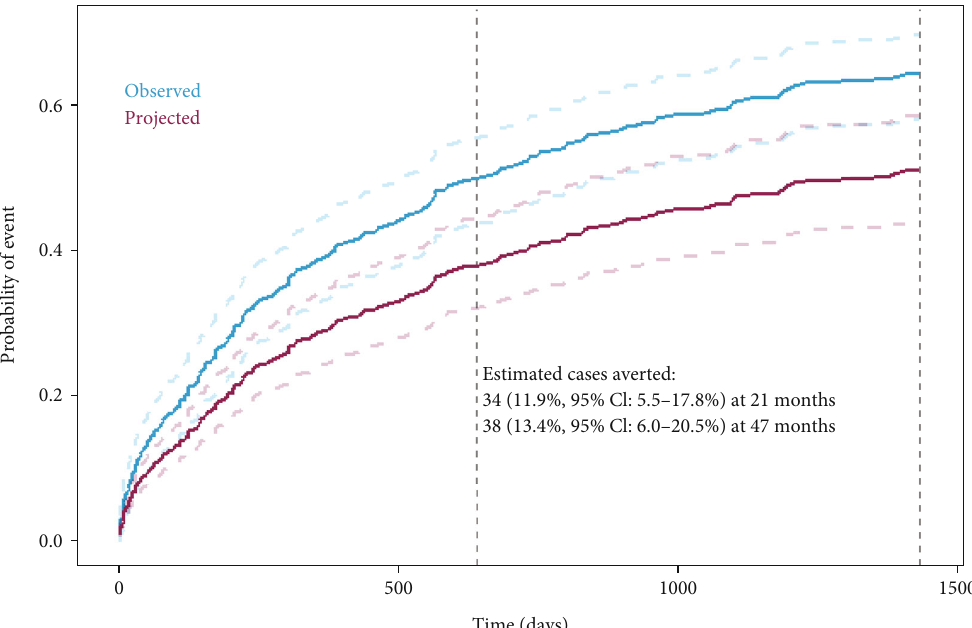
Figure 1: Cumulative incidence plot of the primary composite endpoint including adverse cardiovascular and limb events. (i) The projected cumulative incidence was calculated by fi rst multiplying the observed cumulative hazard by the hazard ratio, its lower con fi dence interval (CI) limit, and its upper con fi dence interval limit reported in the COMPASS trial subgroup analysis ( HR = 0 : 69 , 95% CI: 0.56-0.85 [8]). It was then transformed to the projected cumulative